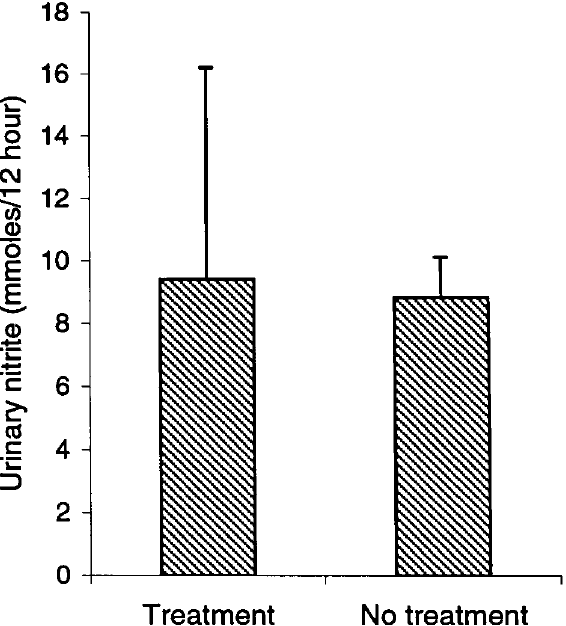
FIG. 3. The effect of concurrent anti-inflammatory medication on 12-h urinary nitrite was assessed among patients with active inflammatory bowel disease ( n = 32). No statistical difference was detected between the groups.